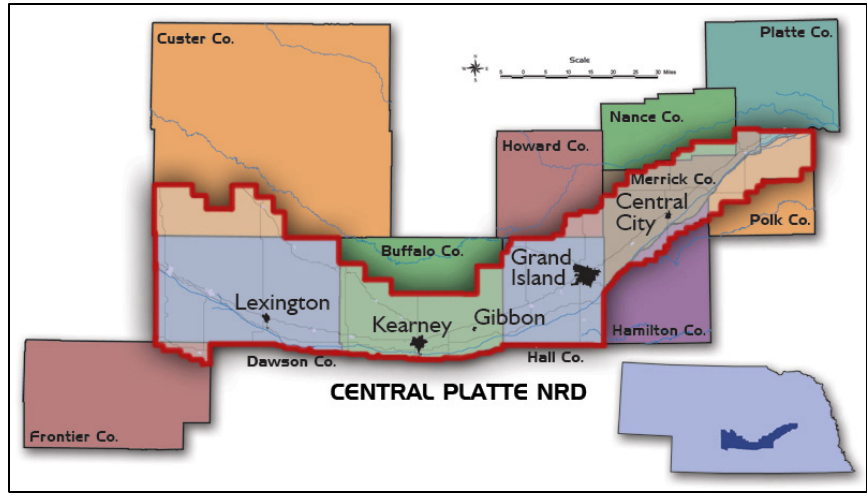
Figure 1. Counties within and surrounding the CPNRD in Nebraska [22].